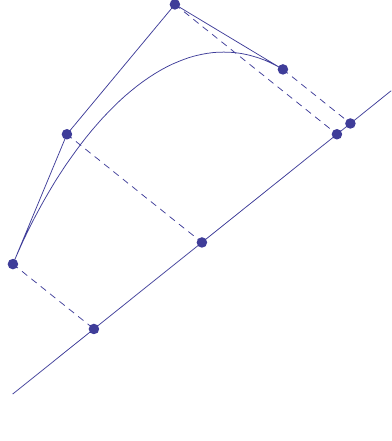
Fig. 1 Monotonicity preservation of a representation of